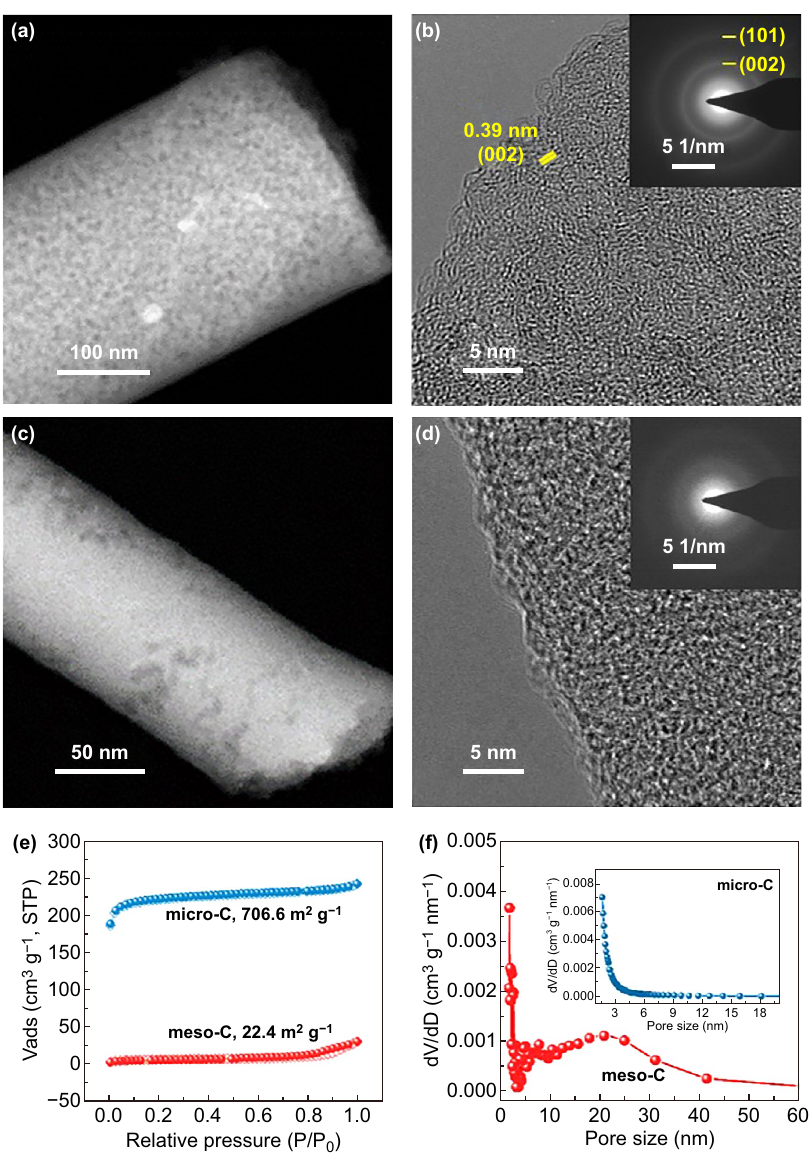
Fig. 2 Structural characterizations. a HAADF-STEM and b HRTEM images of meso-C. Inset: the corresponding SAED pattern. c HAADF- STEM and d HRTEM images of micro-C. Inset: the corresponding SAED pattern. e Nitrogen adsorption–desorption isotherms and f pore size distribution curves of meso-C and